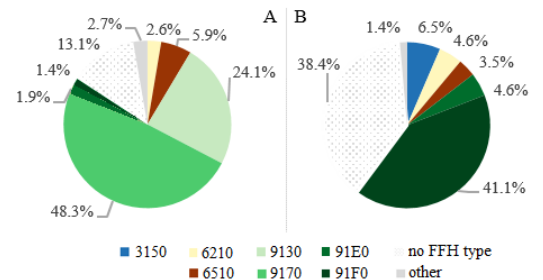
Figure 1. The proportional coverage of different FFH classes of the two research areas. A: research area in the Vienna Woods (study site A). B: research area Donau-Auen National Park (study site B). The description of the different classes is shown in Table 1. The class "others" refers to FFH types with a coverage of less than 1% of the total research